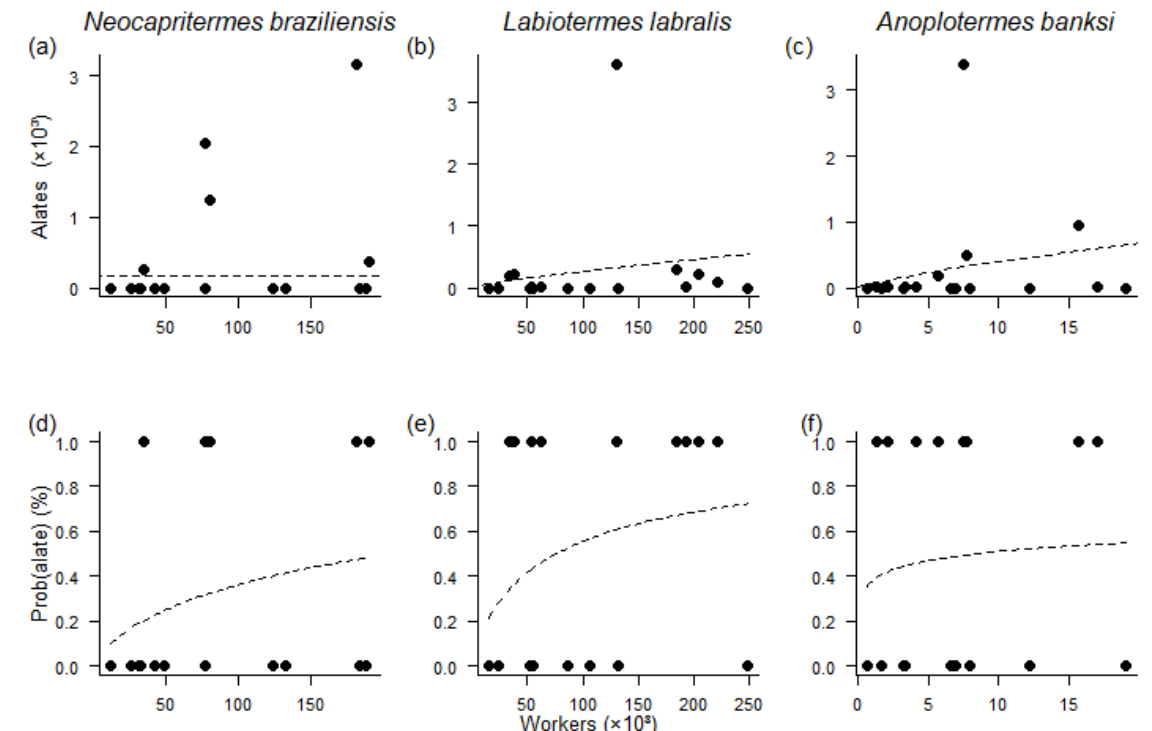
Fig 3 . Whole-colony scalings of reproduction in three Amazonian termite species. Points represent colonies. Dashed lines represent statistically non-significant GLM fits at the 0.05 level, as indicated in Table 2. Prob(alate): probability of producing